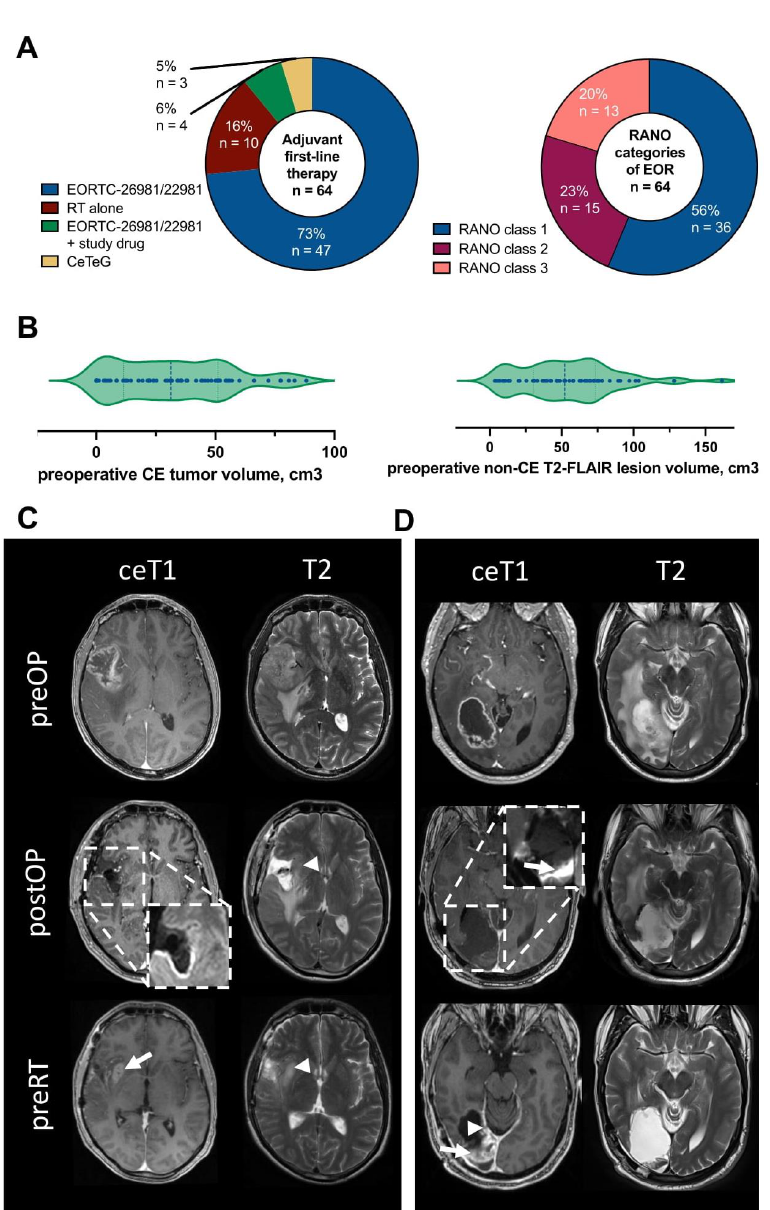
Figure 1. Baseline patient characteristics and volumetric analyses. ( A ) Distribution of administered first-line adjuvant therapies (left) and stratification of all patients according to the RANO resect classes for extent of resection (right) in patients with newly diagnosed glioblastoma CNS WHO grade 4 after undergoing microsurgical tumor resection ( n = 64). ( B ) Preoperative CE tumor and non-CE T2-FLAIR lesion volume (in cm 3 ) before microsurgical tumor resection ( n = 64). ( C , D ) Contrast-enhancing T1- and T2-weighted MRI is shown for two patients displaying volumetric changes in CE and non-CE compartments due to ( C ) residual non-CE T2-FLAIR lesion progression (arrowheads) and break- down of the blood–brain barrier leading to new CE tumor (arrow), and ( D ) postoperative ischemia (arrows in diffusion-weighted imaging inlay) and unspecific changes such as surgical scarring (ar- rowhead). Abbreviations: CE—contrast-enhancing; ceT1—contrast-enhancing T1-weighted MRI; CeTeG: RT/TMZ → TMZ/CCNU; CNS—central nervous system; EOR—extent of resection; EORTC 26981/22981: RT/TMZ → TMZ; preOP—preoperative MRI; postOP—immediate postoperative